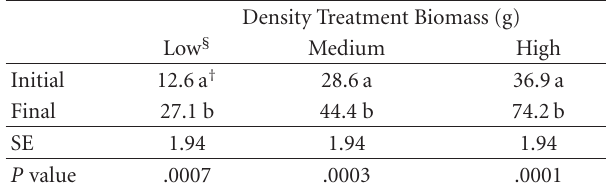
Table 3: Mean initial and final biomass in the low, medium, and high earthworm densities at 31% gravimetric soil moisture